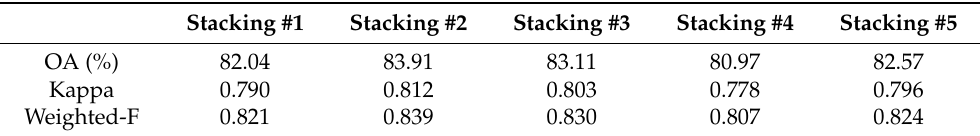
Table 5. Overall accuracies, kappa values, and weighted-average F-scores of the stacking models (meta-classifier =